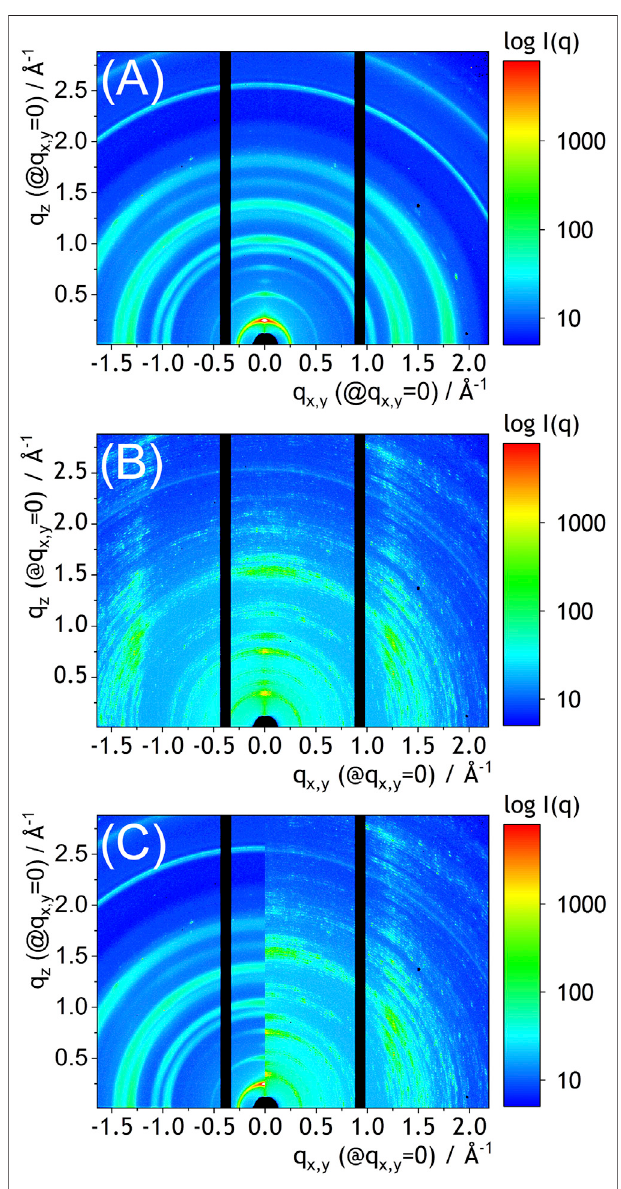
FIGURE4| GIWAXSpatterns(12.85 keV)ofthesprayedcoatedNDIC8: P3HT fi lm (A) , the sprayed-coated and solvent annealed NDIC8:P3HT fi lm, and their comparison in the common coordinate system (C) . Note that the patterns represent unwarped, non Fraser-corrected detector data. Hence,theq z andq x,y arepreciseonlyatq x,y (cid:1) 0andq z (cid:1) 0.Atnonzeroq x,y for q z and q z for q x,y the q-scale is